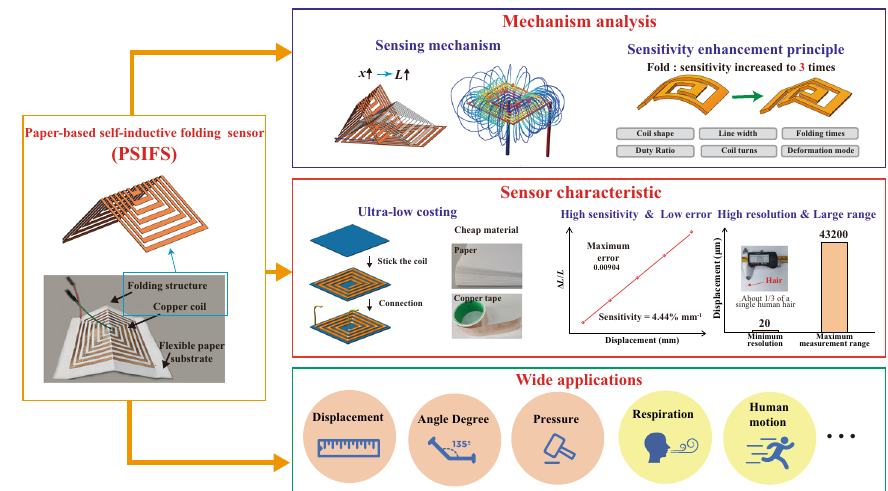
Fig. 1 Schematic of PSIFS. The structure, mechanism, characteristics and applications of